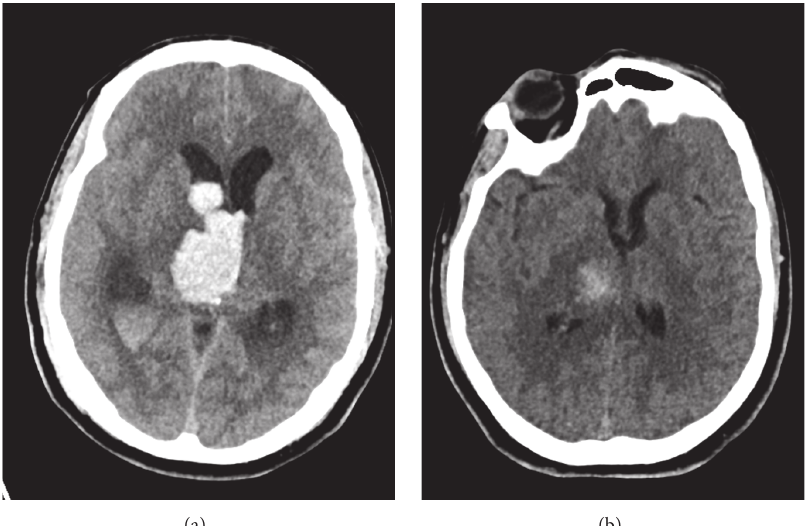
Figure 1: Computed tomography (CT) of the head. (a) CT head on admission showing a right thalamic hemorrhage with intraventricular extension. Note the obstructive hydrocephalus. (b) CT head on hospital day 9 showing evolution of the right thalamic hemorrhage and resolution of the obstructive hydrocephalus with external ventricular drainage (not shown) and after intraventricular tissue plasminogen activator